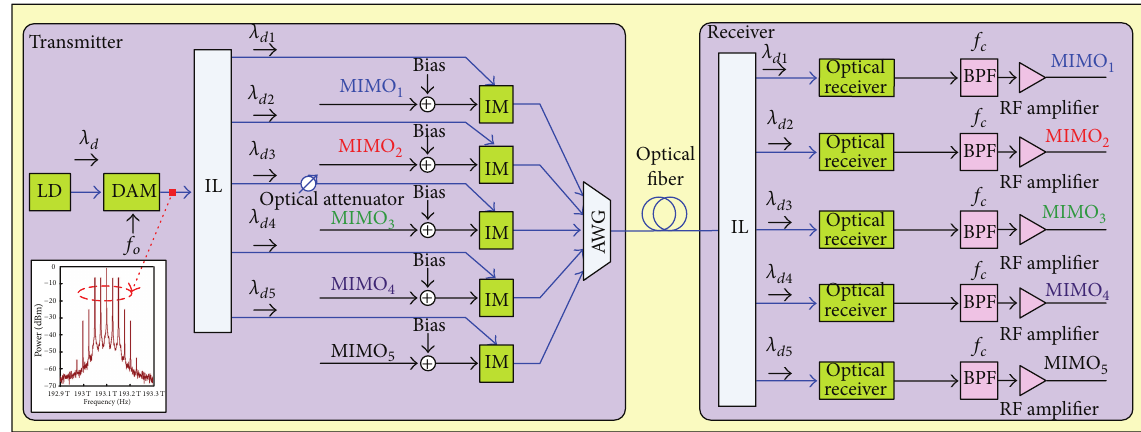
Figure 12: Transmission of five wireless MIMO signals over fiber using the novel